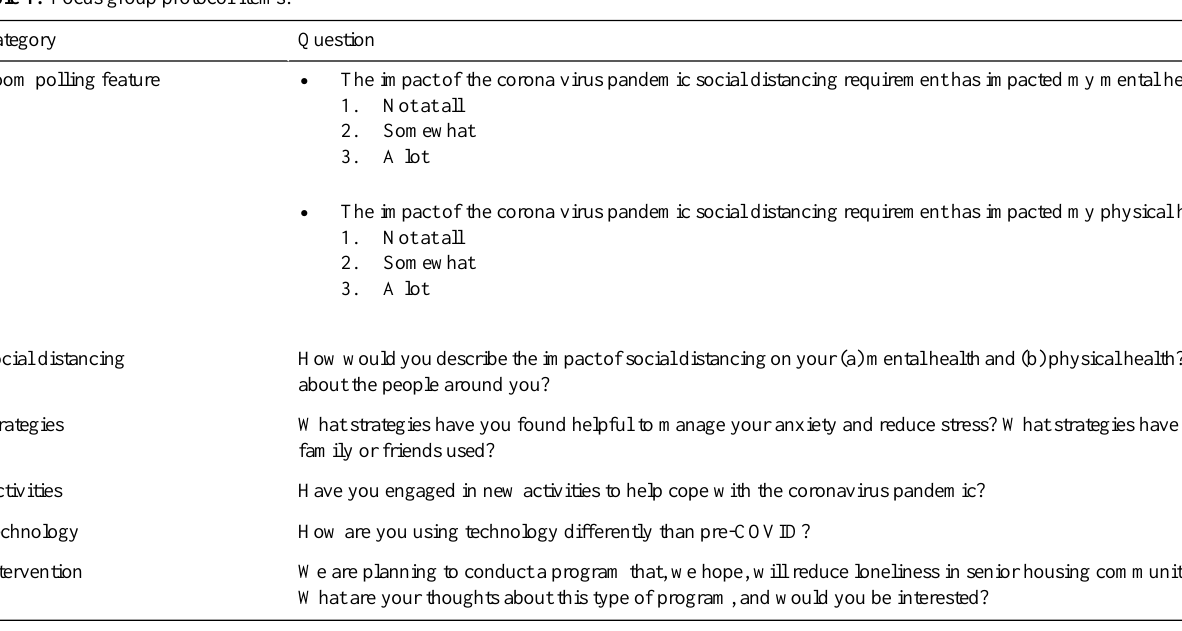
Table 1. Focus group protocol